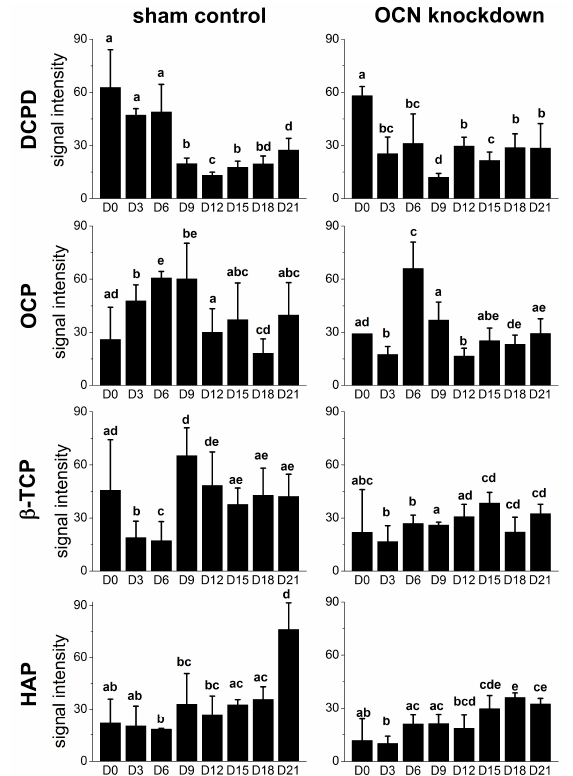
Figure 5. The intensities of peaks of mineral species signals dicalcium phosphate dehydrate (DCPD) at 985 cm − 1 , octacalcium phosphate (OCP) at 957 cm − 1 , β -tricalcium phosphate ( β -TCP) at 970 cm − 1 , and hydroxyapatite (HAP) at 960 cm − 1 along the time course of osteogenic differentiation. Spectra were collected on day 0, 3, 6, 9, 12, 15, 18, and 21 after the induction. Data are shown as mean ± SD. One-way analysis of variance (ANOVA) followed by running Tukey’s post-hoc tests was performed for multiple comparisons. Different letters represent significant differences between groups. For example, a and b represent significant difference, a and bc represent significant difference, whereas ab and bcd do not. A p value less than 0.05 is defined as statistically significant; D = Day.